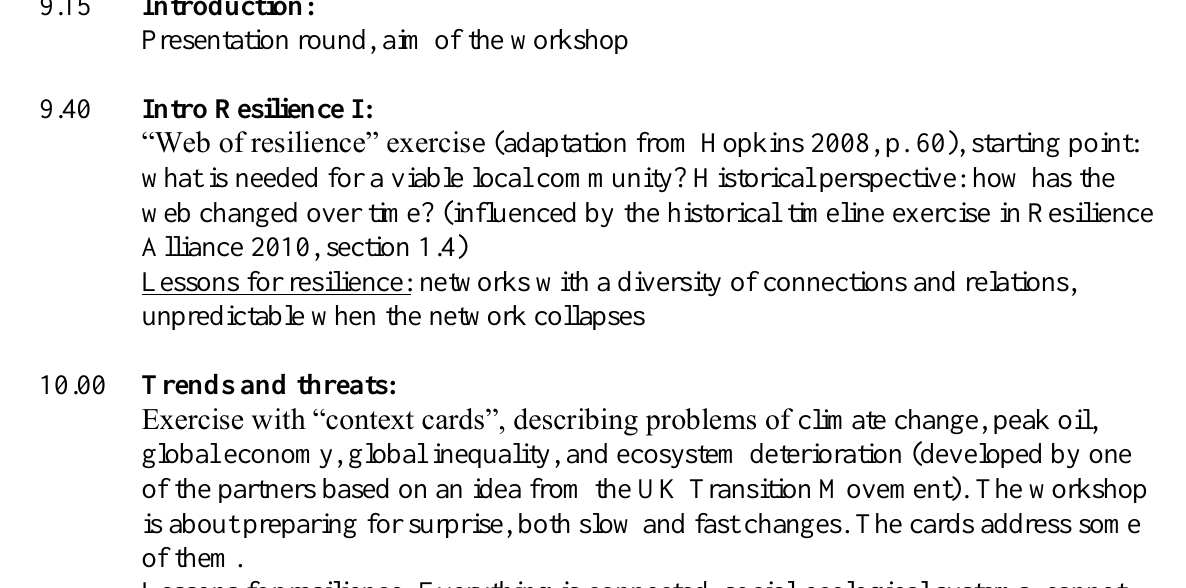
Table A2.1. The workshop